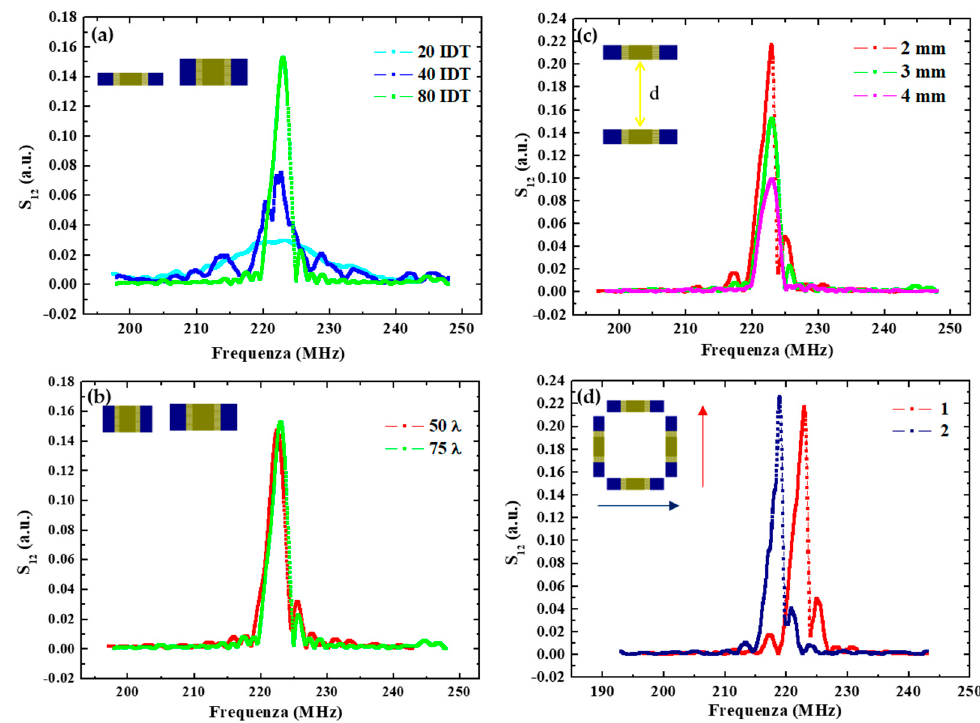
Figure 2. (a) Spectra comparison of SAW delay lines with different IDT pair numbers; (b) with dif- Figure 2. ( a ) Spectra comparison of SAW delay lines with different IDT pair numbers; ( b ) with ferent IDT overlap lengths; (c) with IDT transducers placed at different distances (d=2 mm, 3 mm different IDT overlap lengths; ( c ) with IDT transducers placed at different distances (d = 2 mm, 3 mm and 4 mm); (d) with different SAW direction propagation. and 4 mm); ( d ) with different SAW direction